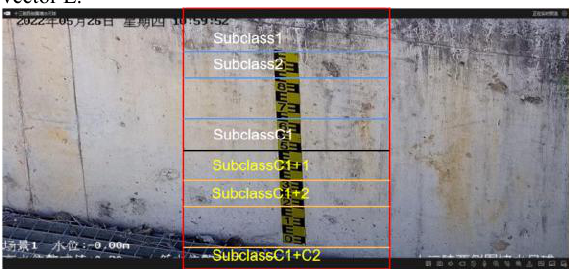
Figure 7 . Classification of water level information